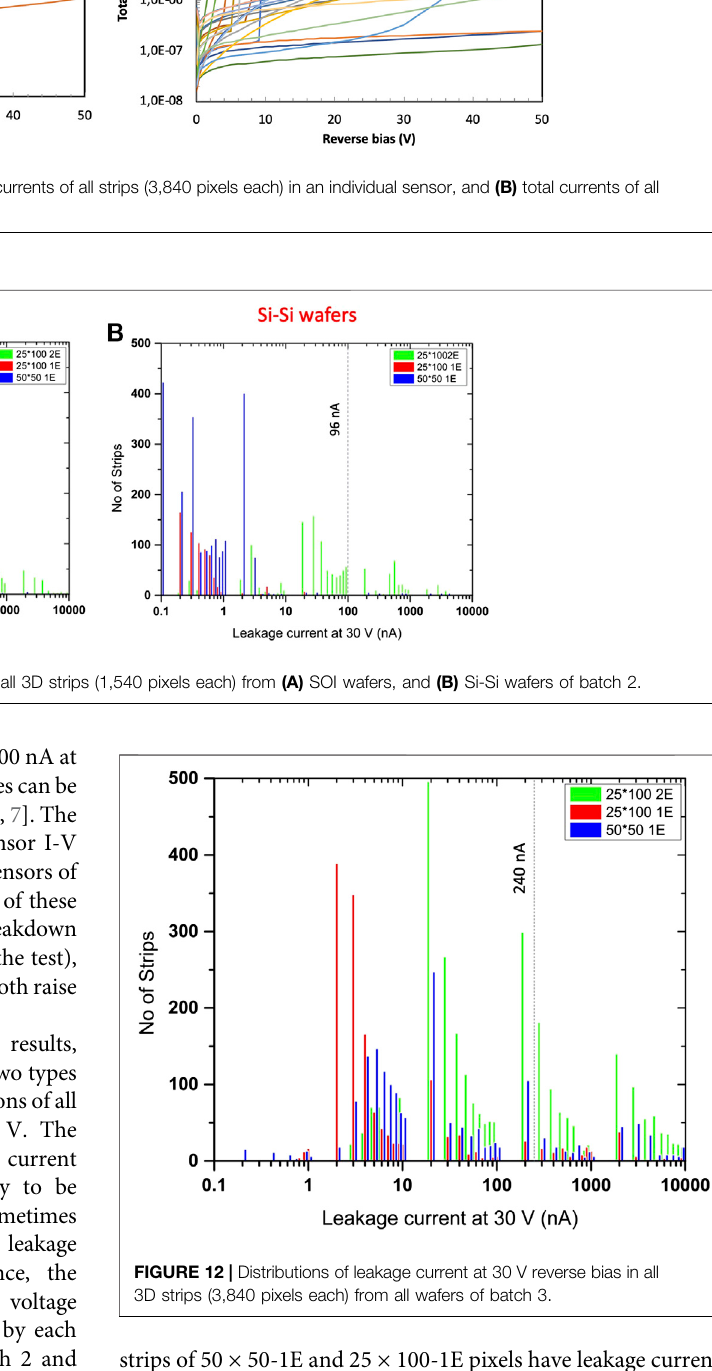
Frontiers in Physics |